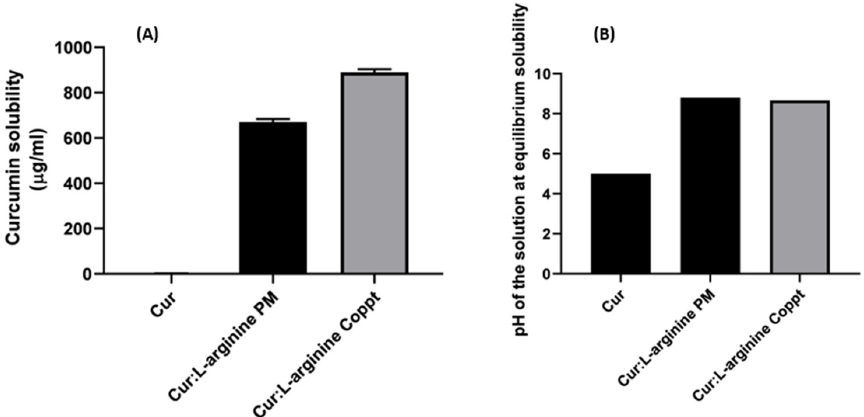
Figure 2. Solubility ( A ) and pH of the solutions measured at equilibrium for curcumin and curcumin–L-arginine physical (PM) and coprecipitated (Coppt) mixtures ( B ) (results are expressed as mean ± SD; n = 3).